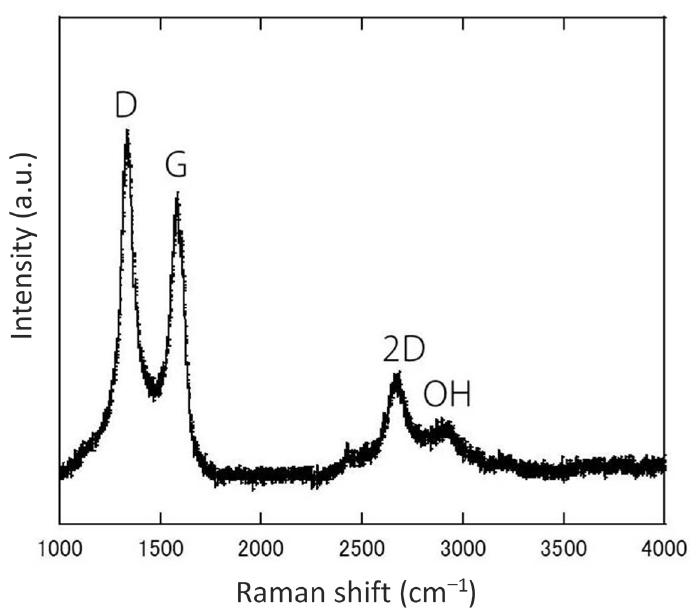
Figure 9. Raman spectrum of nanoparticle products formed by pulsed discharge plasma [40].